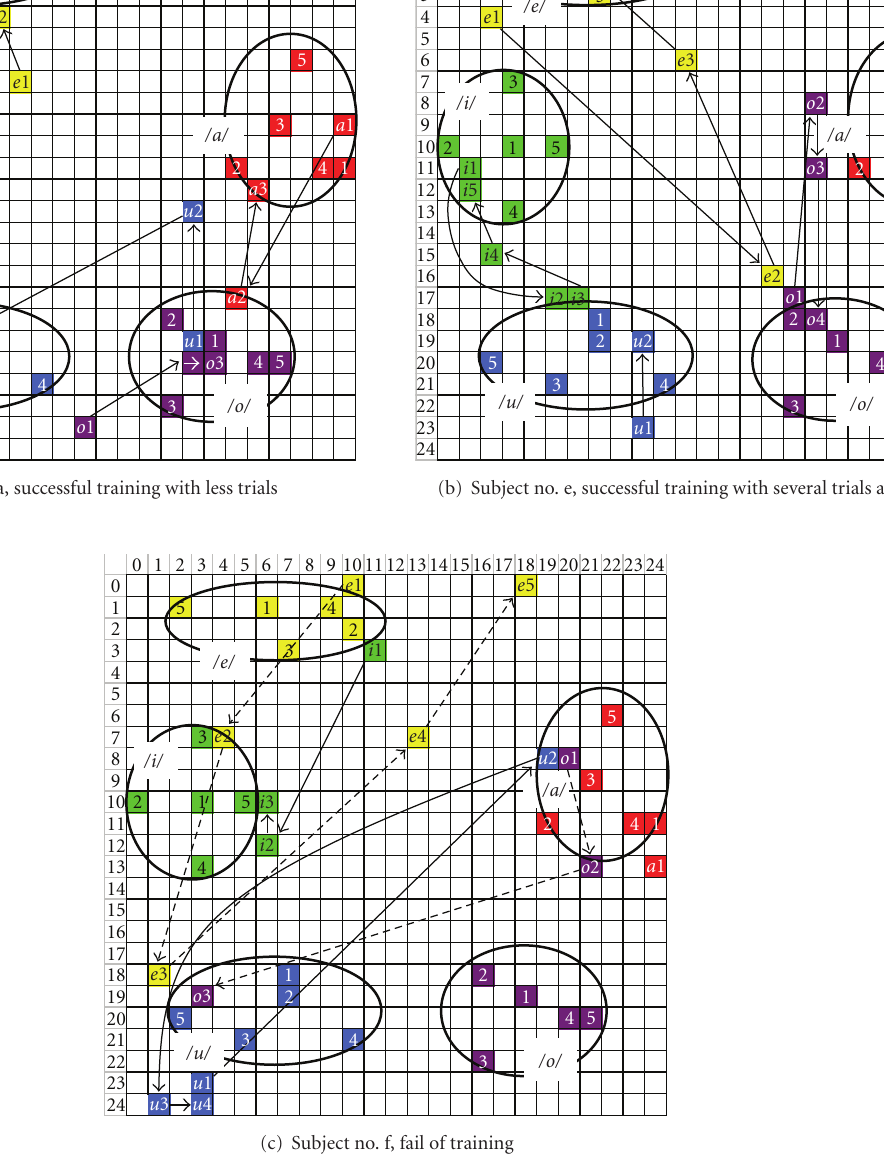
Figure 8: Example trajectories in